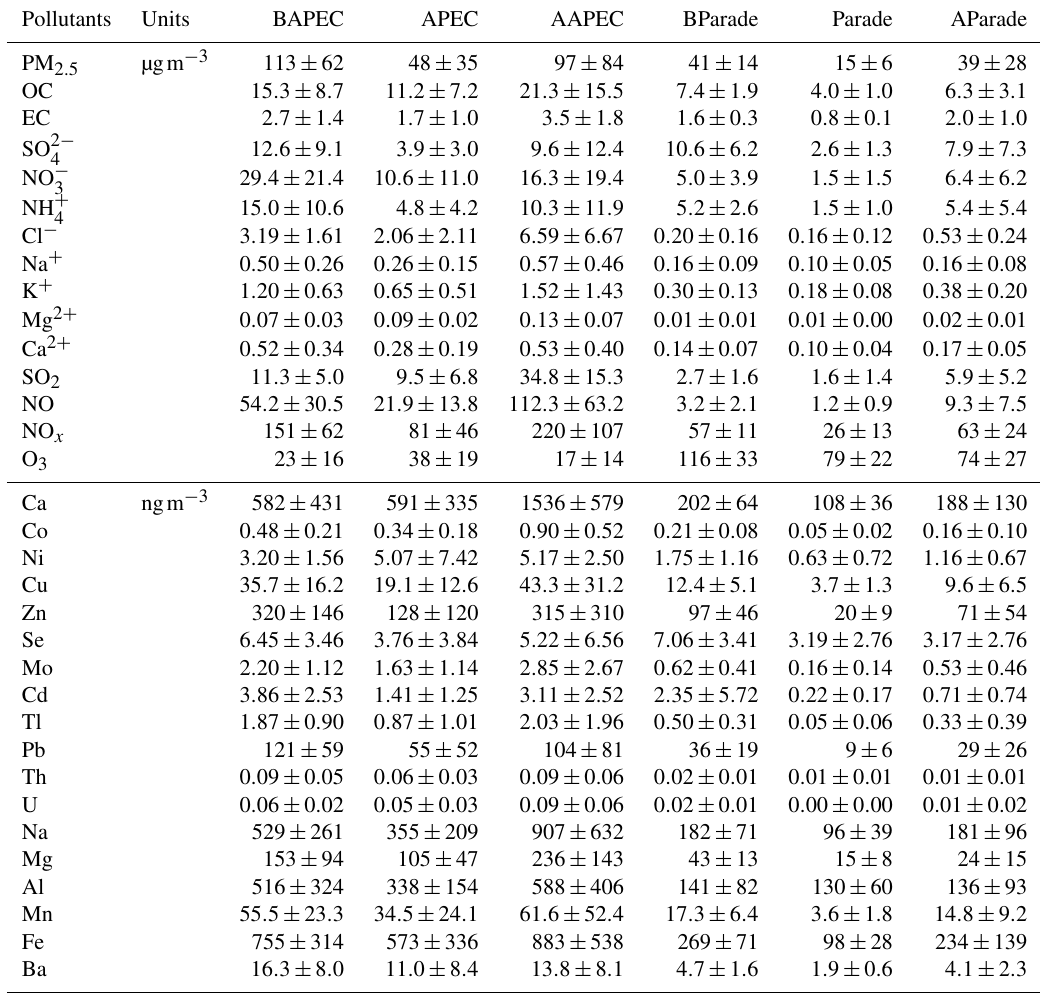
Table 4. Statistical summary showing the mean concentrations and SDs of PM 2 . 5 , gaseous pollutants, and PM 2 . 5 components. BAPEC and BParade: before APEC and before Victory Parade; AAPEC and AParade: after APEC and after Victory Parade.